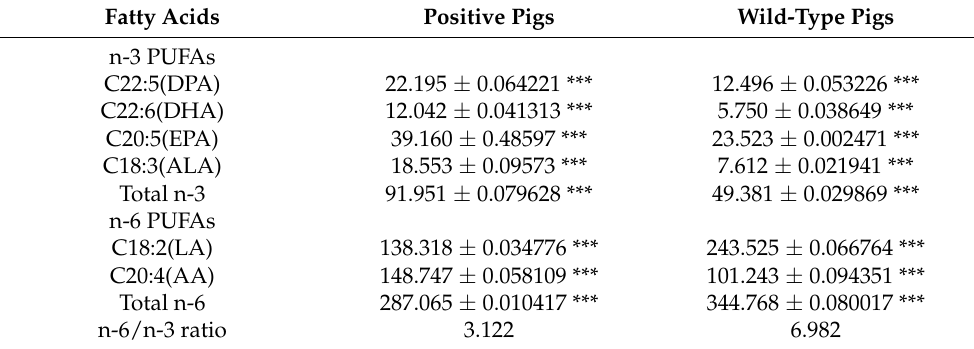
Table 1. Analysis of PUFAs in wild-type pigs and positive pigs ( IGF-1 and Fat-1 knock-in ) . Fatty Acids Positive